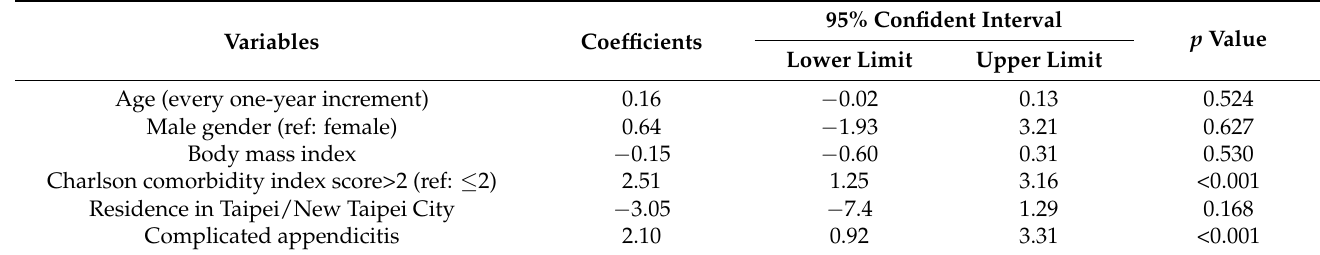
Table 4. Adjusted multivariate analysis to predict inpatient length of